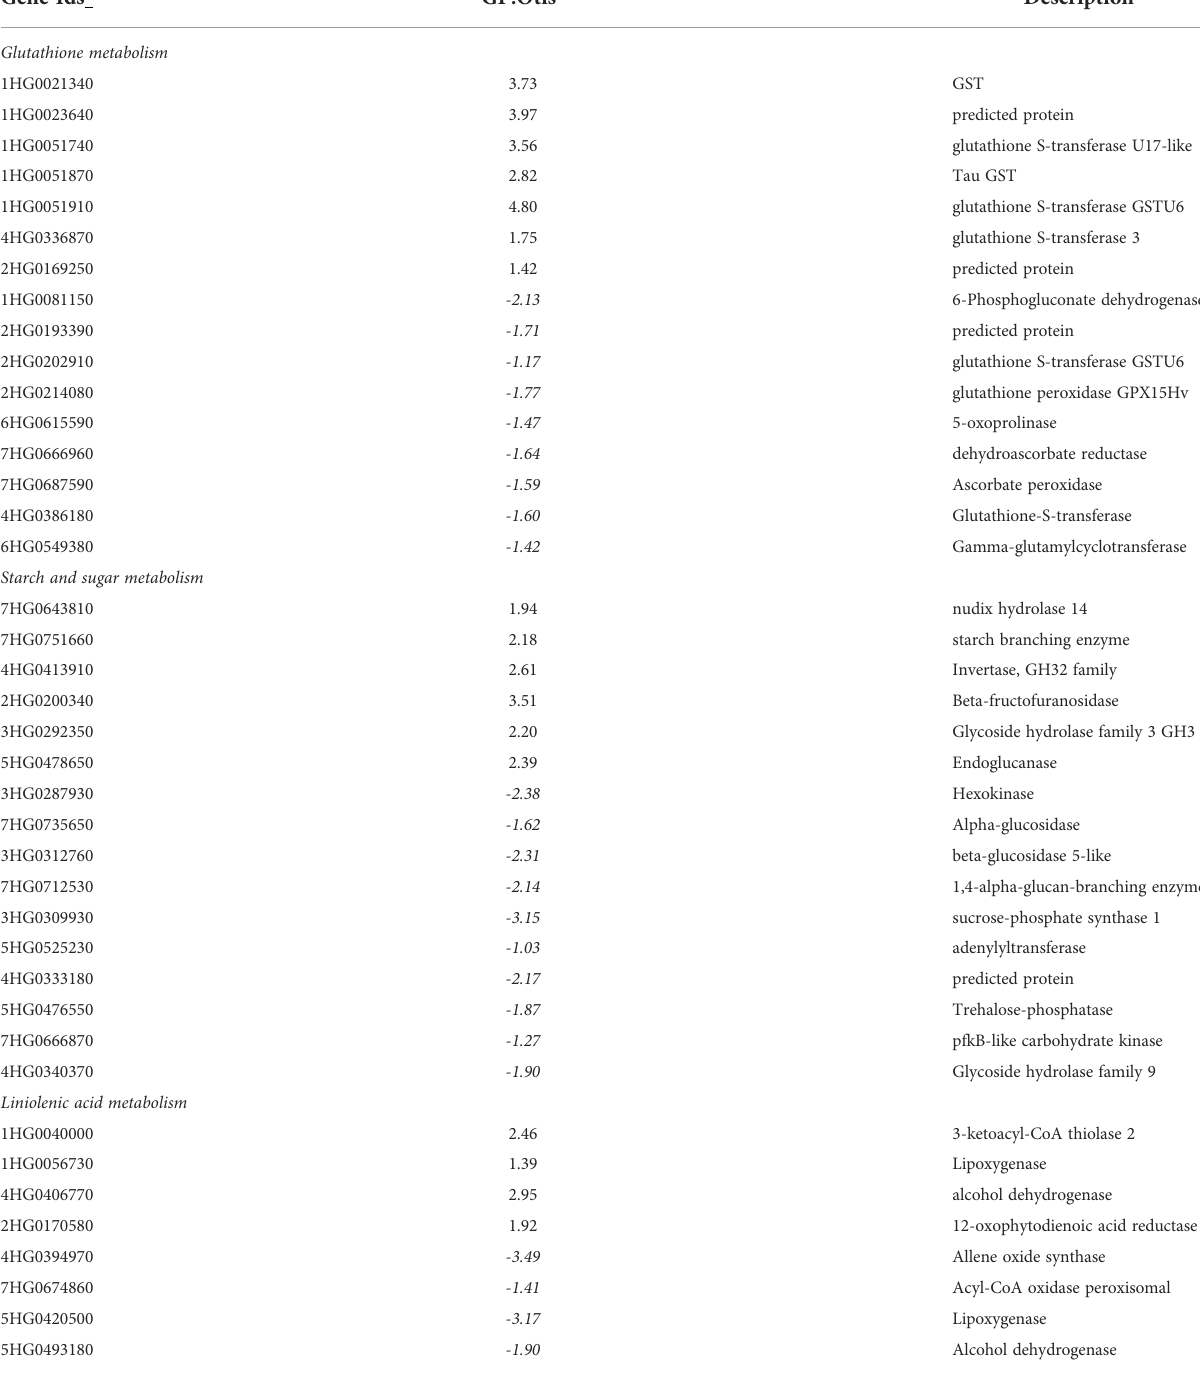
TABLE 1 KEGG pathways enriched among differentially expressed genes in GP and Otis under non-stress